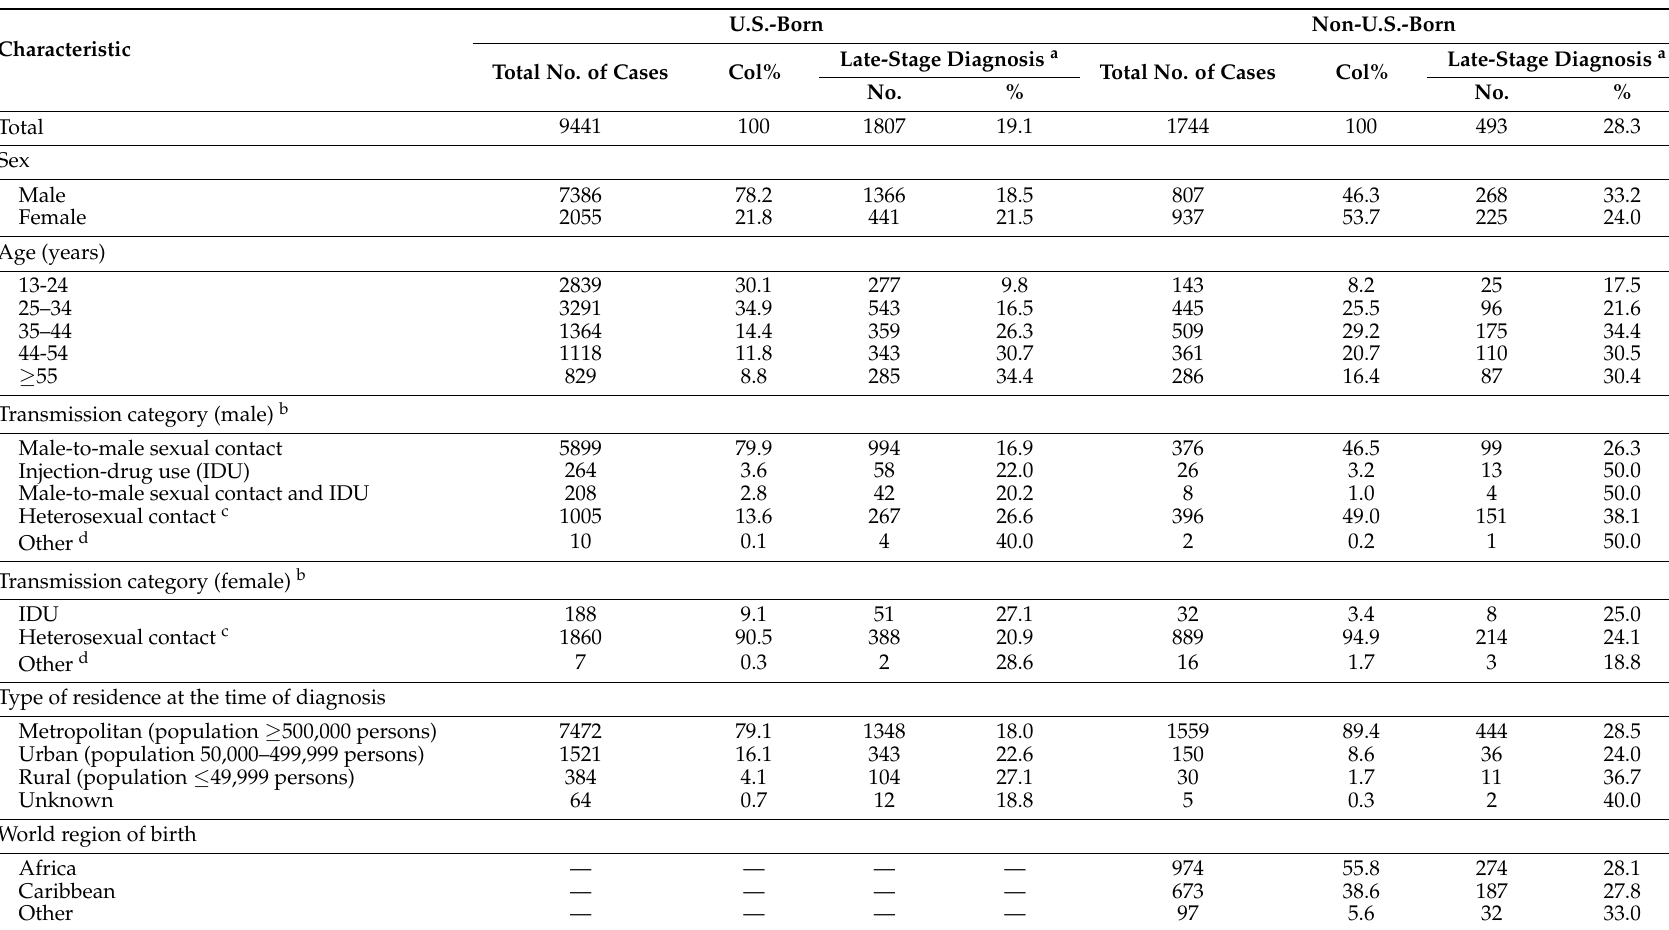
Table 1. Late-stage human immunodeficiency virus (HIV) diagnosis (Stage 3, acquired immunodeficiency syndrome (AIDS) at the time of diagnosis) among U.S.-born and non-U.S.-born blacks aged ≥ 13 years by selected demographic characteristics, National HIV Surveillance System, 40 U.S. areas,